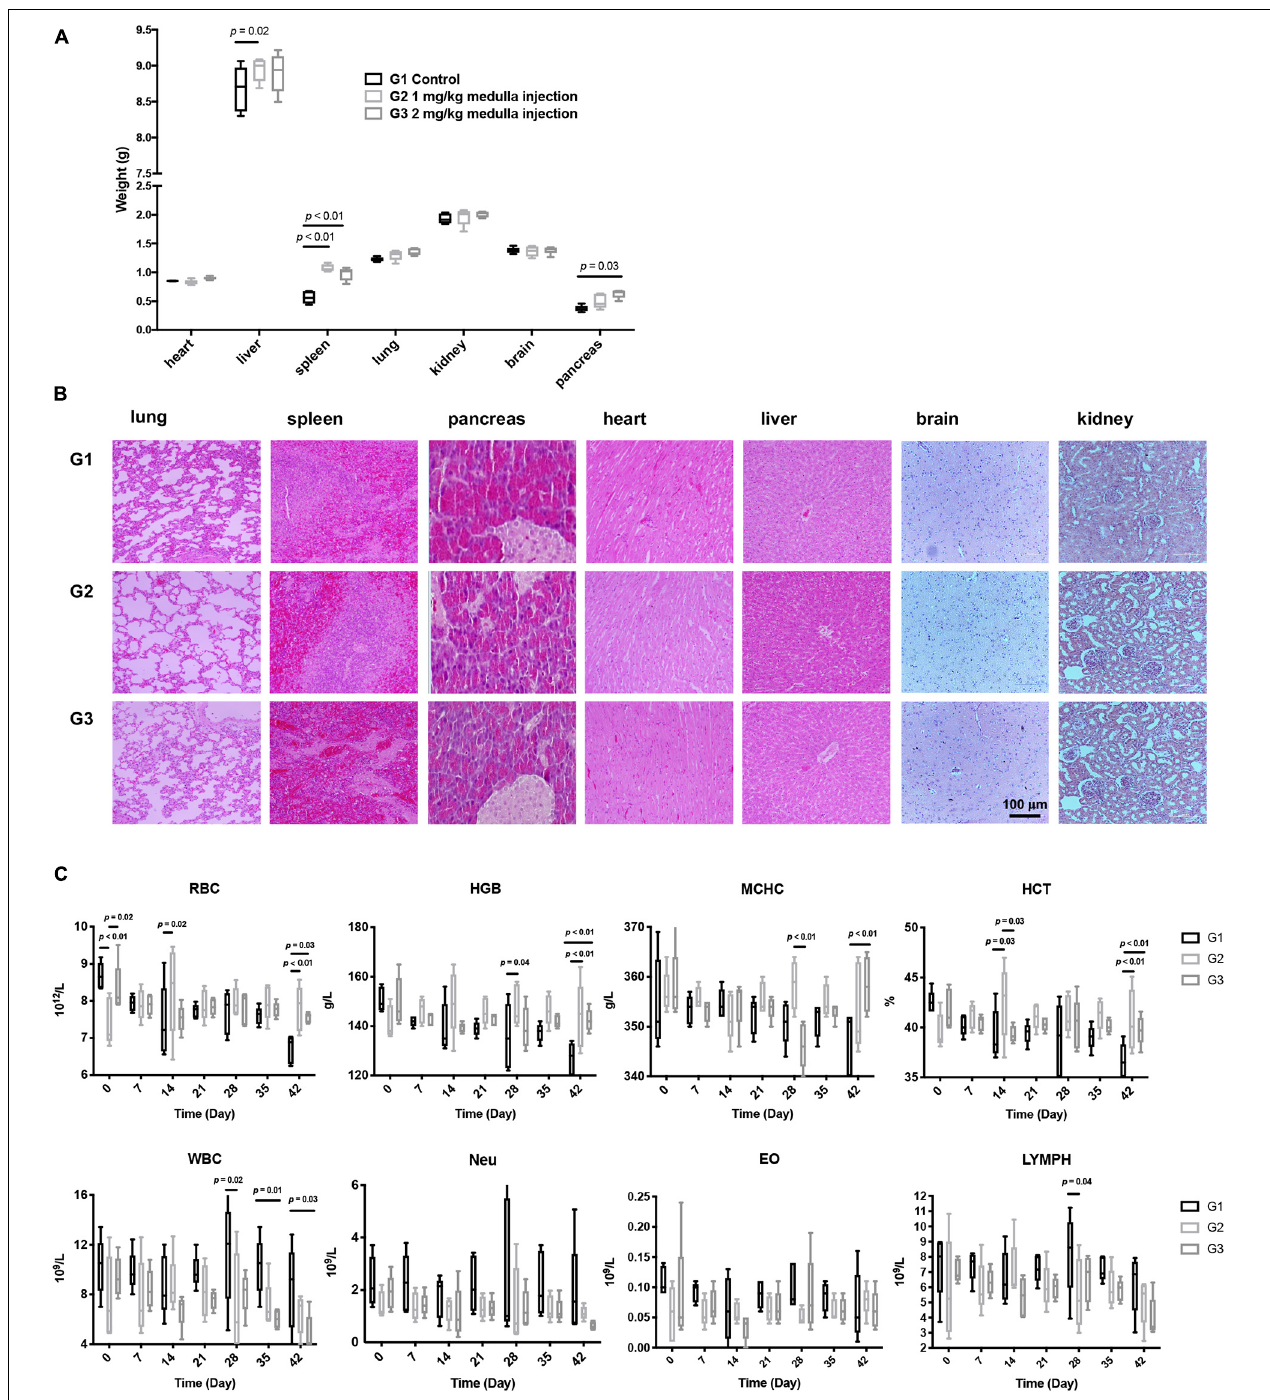
FIGURE 2 | Toxicological experiments of ADPN based on local medulla injection. (A) The weight of various organs. (B) H&E staining images of various organs, scale bar = 100 µ m. (C) The changes of red blood cell (RBC), hemoglobin (HGB), mean corpuscular hemoglobin concentration (MCHC), hematocrit (HCT), eosinophilic granulocyte, lymphocyte, and leukocyte levels after ADPN administration among the G1, G2, and G3 groups, n = 5.